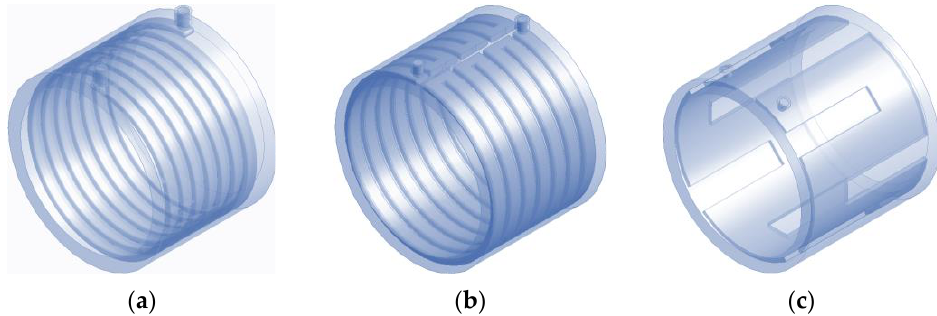
Figure 4. Three kinds of water channel structures. ( a ) Axial spiral type. ( b ) Axial S type. ( c ) Circumferential S type.